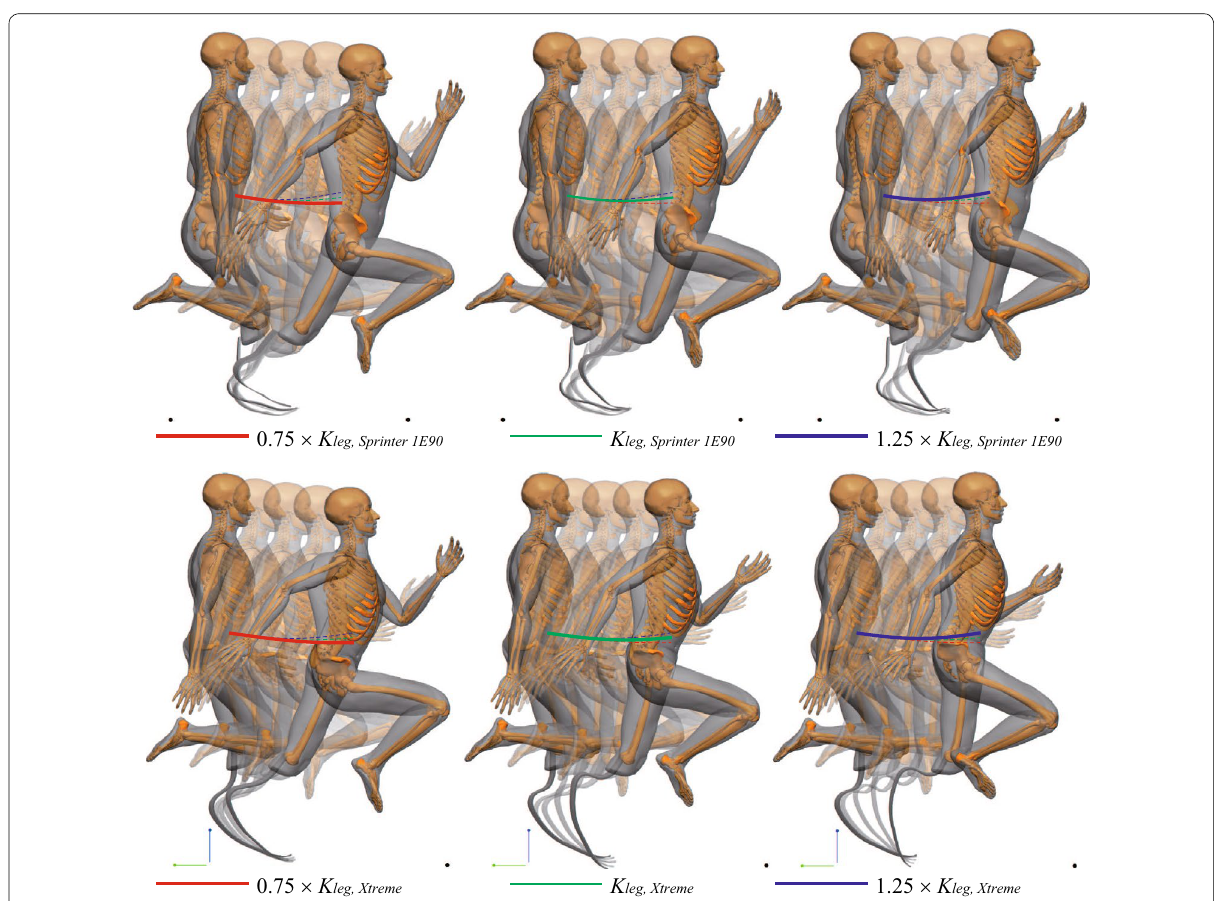
Fig. 6 Simulated whole-body sprint motion and COM trajectory during the stance phase with different RSPs. Top row: Sprinter 1E90, bottom row: Xtreme, left (red): 75% of K leg , middle (green): 100% of K leg , and right (blue): 125% of K leg